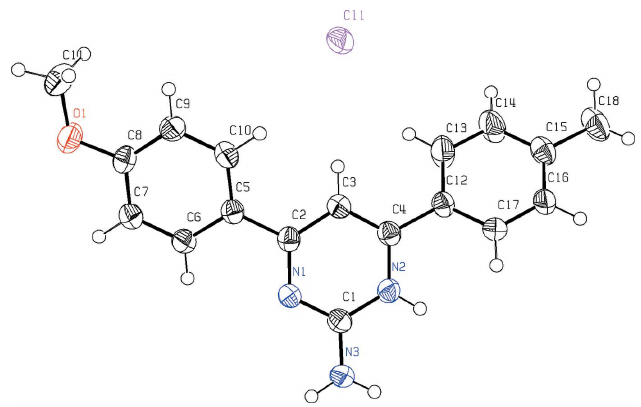
Figure 1 The molecular structure of the title compound, showing the atom- labelling scheme and displacement ellipsoids drawn at the 30% probability level.